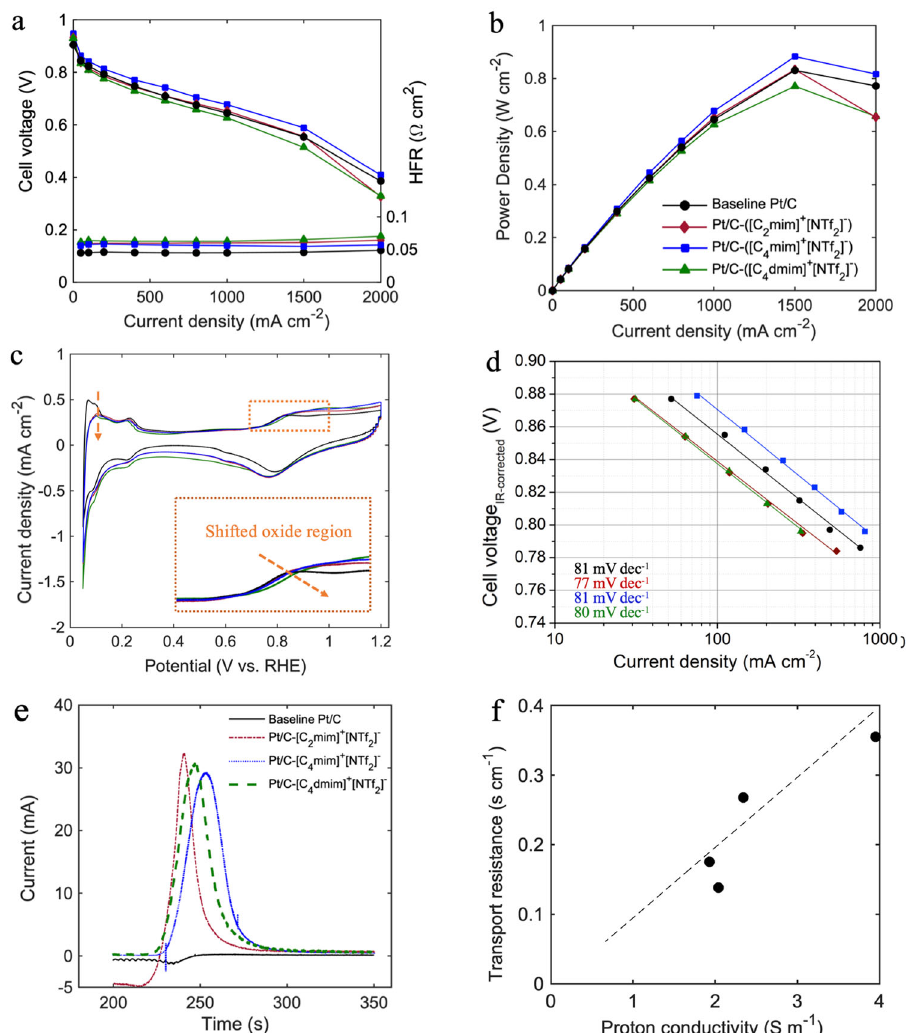
Fig. 4 | Electrochemical characterization of IL-containing MEAs obtained after three voltage recovery cycles vs. baseline Pt/C after two voltage recovery cycles evaluated at 80°C and 100% RH. a H 2 /air polarization curves, b power densityat150kPa abs totalpressure, c cyclicvoltammogramsrecordedinH 2 /N 2 and 100kPa abs total pressure, d H 2 /O 2 Tafel plots at 150kPa abs total pressure, e CO-